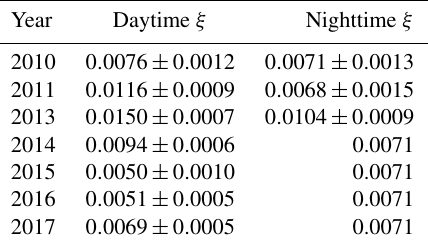
Table 4. Estimates of scaling factor ξ ± 95% confidence intervals used for open-path flux correction. ξ describes the portion of the self-heating correction term, given by Burba et al. (2006) for verti- cally installed instruments, that is needed to correct OP fluxes de- termined with inclined gas analyzers. The scaling factor was opti- mized as a parameter of a nonlinear function where CP data were regarded as true fluxes. It was therefore determined for years when parallel CP and OP measurements were available. In the case of an optimization converging to unreasonable values (below 0), we used the median of the remaining ξ